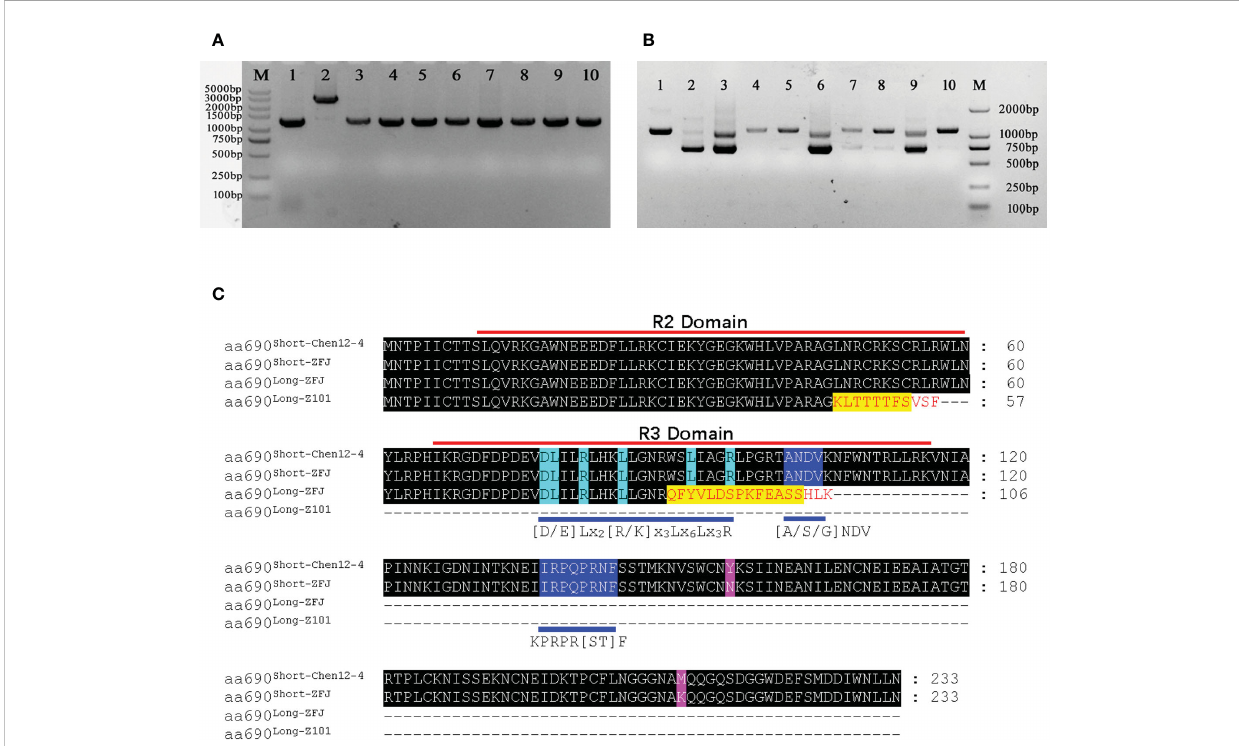
FIGURE 10 PCR ampli fi ed the gDNA and CDS from different pepper accessions and sequence alignment of different amino acid sequences. (A) PCR products for the gDNA of the CA10g11690 in different pepper accessions. (B) RT-PCR products for the CDS of the CA10g11690 in different pepper accessions. Lane 1-10: Z101-M, Chen12-4, ZFJ, Chen12-3, M38, LJBN002, THIP, BZ, ZL and S18. (C) Speculative amino acid sequences of transcripts in different pepper accessions.